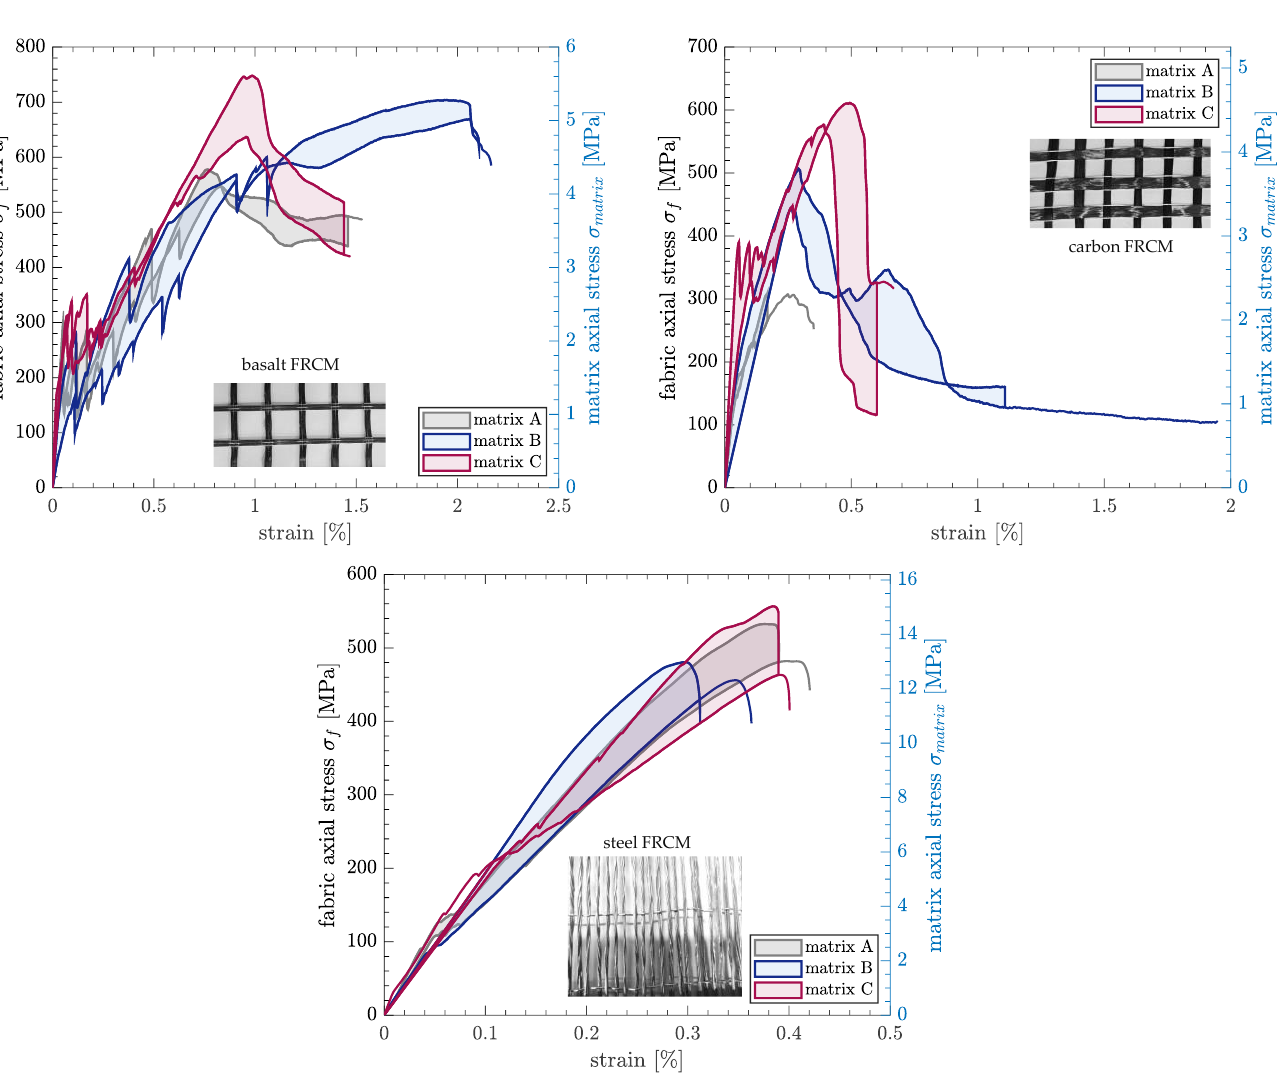
Figure 9. Stress – strain curves of basalt, carbon, and steel FRCM coupons realized with different cement-based matrices.